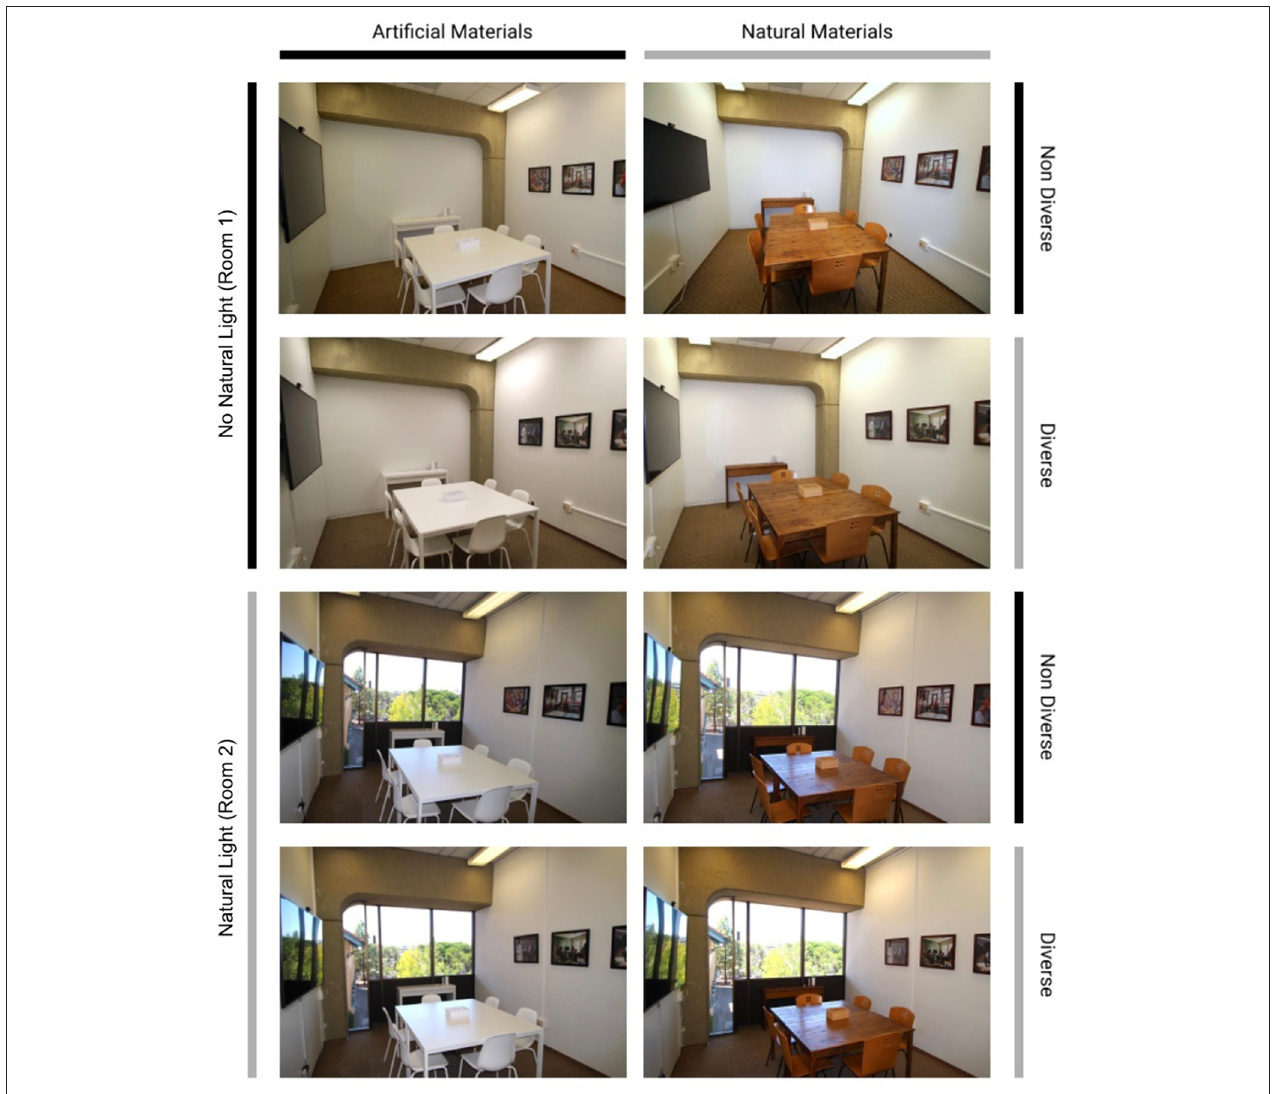
FIGURE 2 | Pictures of the two laboratory rooms located on the lead authors’ university campus that were used in studies 4 and